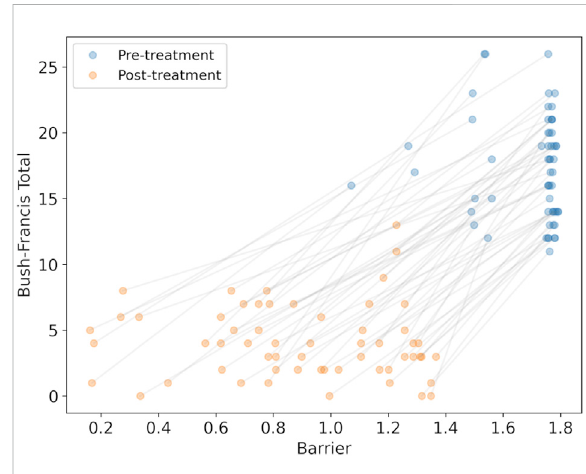
FIGURE 5 The synthesizedBFCRS score versus thebarrier calculated by the model for subjects before and after treatment. The grey lines